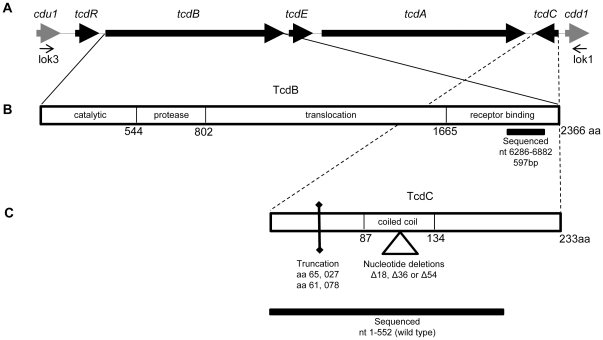
Relative positions of the tcdB and tcdC genes within the PaLoc and the sequences determined in this study.(A) Organisation of the five genes encoded by the 19.6 kb PaLoc of C. difficile, and two flanking genes containing the lok1/3 primer pair [47]. (B) The four functional domains of the 2366 amino acid TcdB protein, [7]. The region of the receptor binding domain (RBD) sequenced is indicated (horizontal black bar). The sequence determined is located within the C-terminal repetitive region which may bind to enteric cells via carbohydrate receptors [60]. (C) The 233 amino acid negative regulator TcdC. The location of the coiled-coil dimerization domain [14] is indicated; deletions found within the repetitive sequences of this domain are indicated by a triangle. The truncations found in PCR-ribotype 027 and 078 strains are indicated by a vertical bar. The sequence determined is indicated by a black horizontal bar.